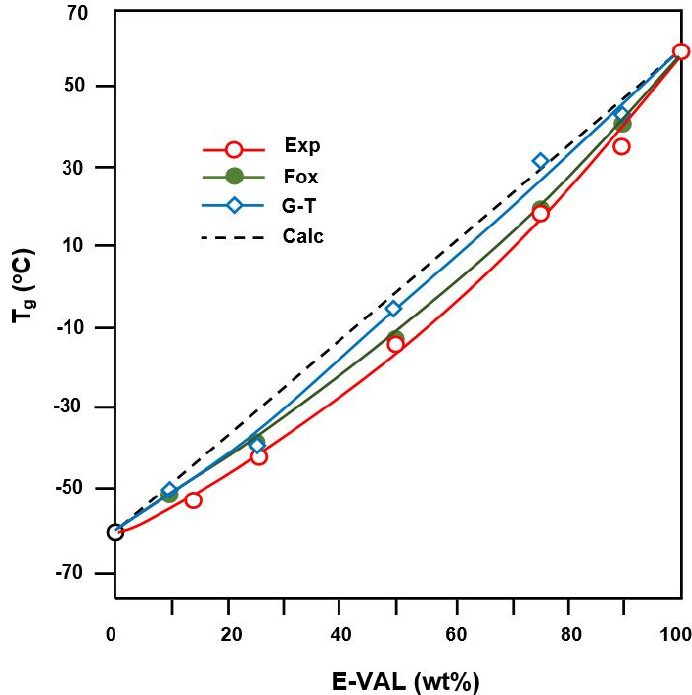
Figure 6. Comparison of T g s of E-VAL / PCL blends with di ff erent compositions determined by experiment, calculation, and using the Fox equation and Gordon–Taylor equation.